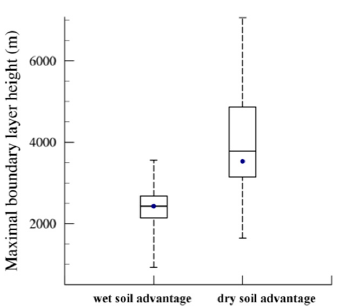
Figure 8. Distributions of maximal boundary layer height in wet soil advantage cases and dry soil advantage cases. The upper and lower of the box show upper quartile and lower quartile, and the line inside represents the median. The upper whisker and lower whisker indicate the maximum and the minimum values in the non-abnormal range, respectively. The blue spot is the average.